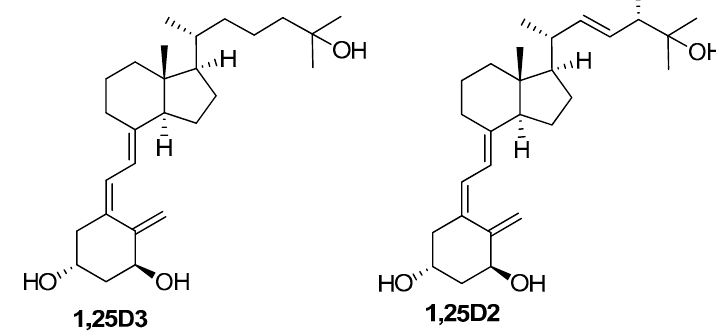
Figure 1. Structures of 1 α ,25-dihydroxyvitamin D 3 (1,25D3) and 1 α ,25-dihydroxyvitamin D 2 (1,25D2).